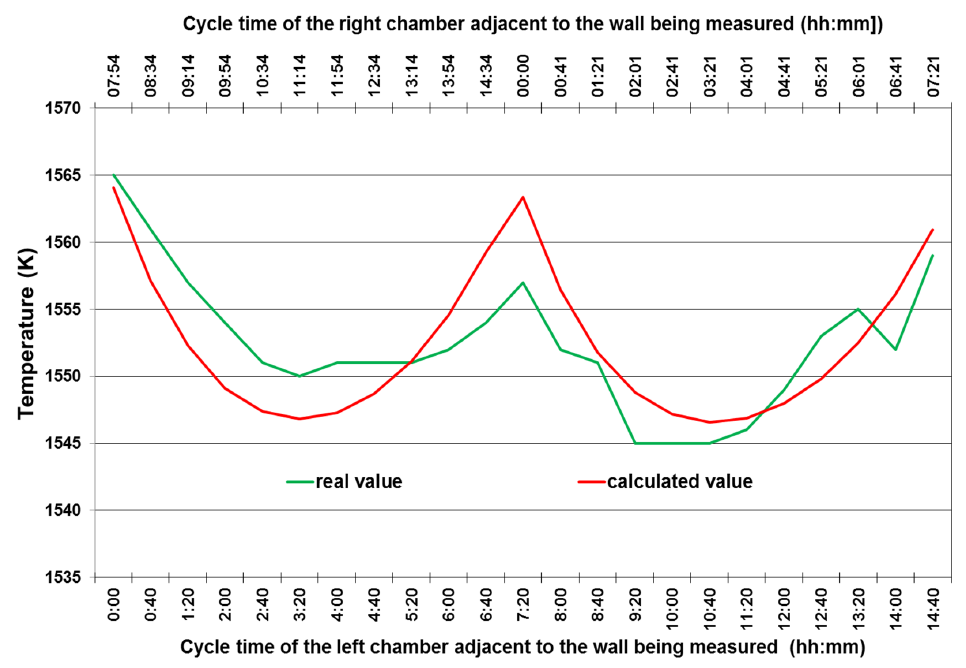
Figure 9. The comparison of the results of the actual temperature measurements in the heating flues of a selected battery (PTU-57) wall with the simulation results obtained with the use of the developed method.